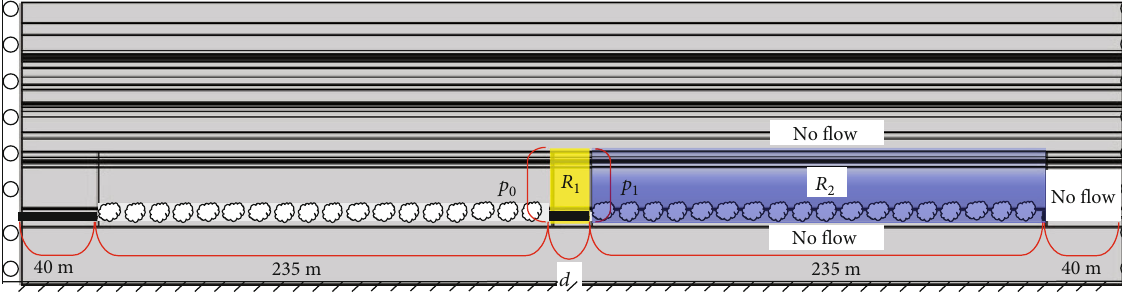
Figure 5: Geometric structure